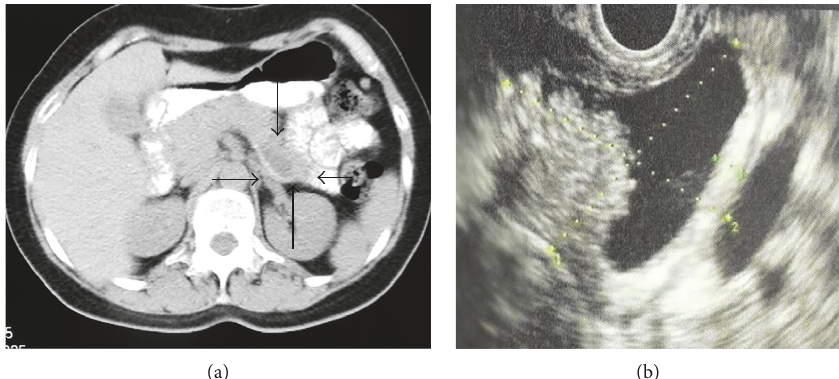
Figure 1: (a) CTscan of the patient in the case presented. The arrows point out the lesion in the tail of pancreas. (b) Endoscopic ultrasound (EUS) of the lesion followed by FNA biopsy.